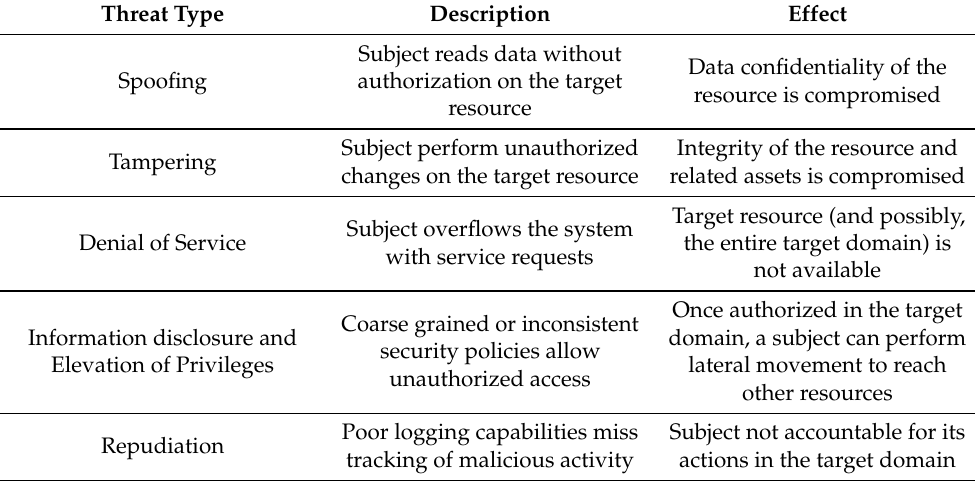
Table 1. STRIDE-based Threat